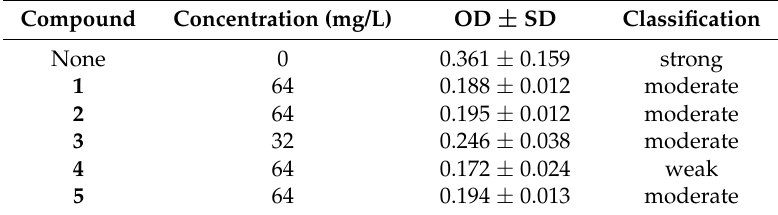
Table 3. Classification of the ability of E. coli ATCC 25922 to adhere to and form a biofilm after an exposure to 1 – 5 .